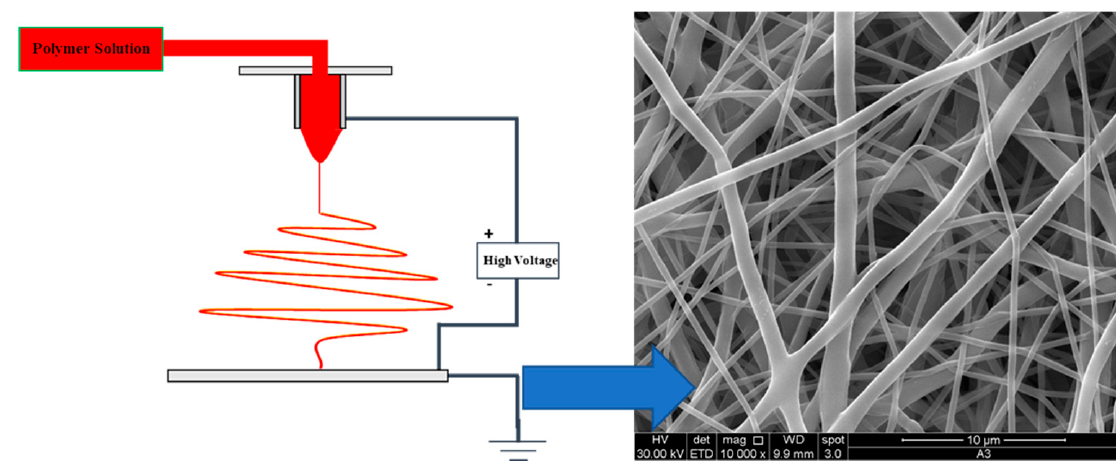
Figure 13. Electrospinning process ( left ) and SEM image of a polycaprolactone (PCL) membrane ( right ).